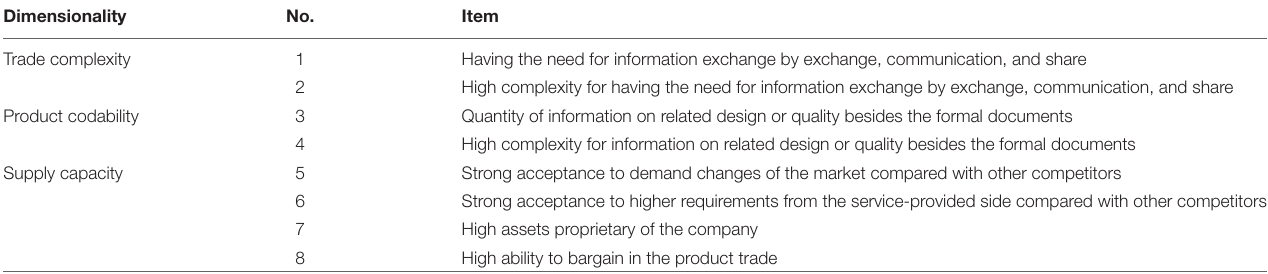
TABLE 2 | Evaluation scale of value-chain potential.